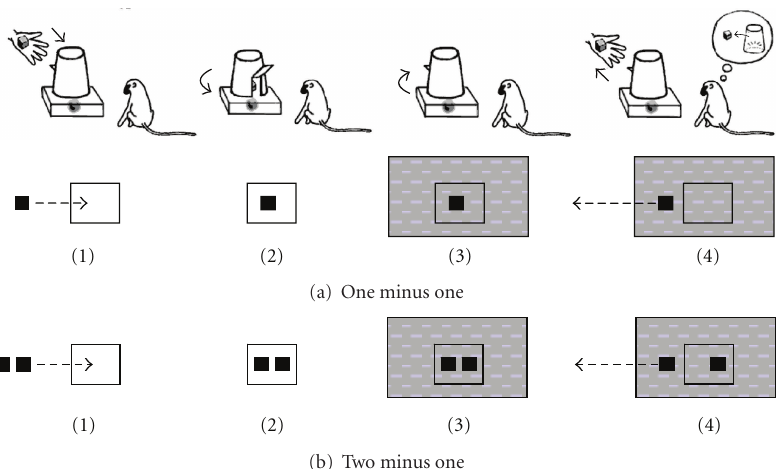
Figure 2: Subtraction sequences for the “1 − 0” (a) and “2 − 1” (b) conditions. The upper row shows the actual movement of the cup and bread pieces, and the two lower rows indicate the hypothesized view (1, 2) and representation (3, 4) of bread pieces in the monkey’s mind.